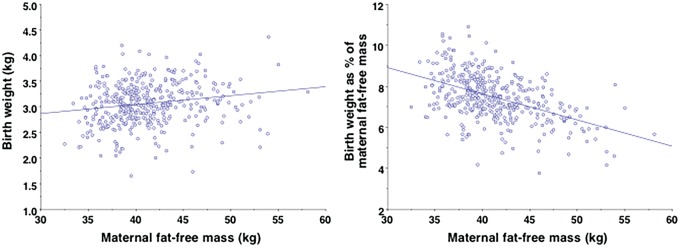
Associations between maternal fat-free mass and offspring size in an Ethiopian birth cohort (n = 403), for (a) absolute birth weight and (b) birth weight as a percentage of maternal fat-free mass. Andersen, Friis, Kaestel, Wells, Girma, unpublished data